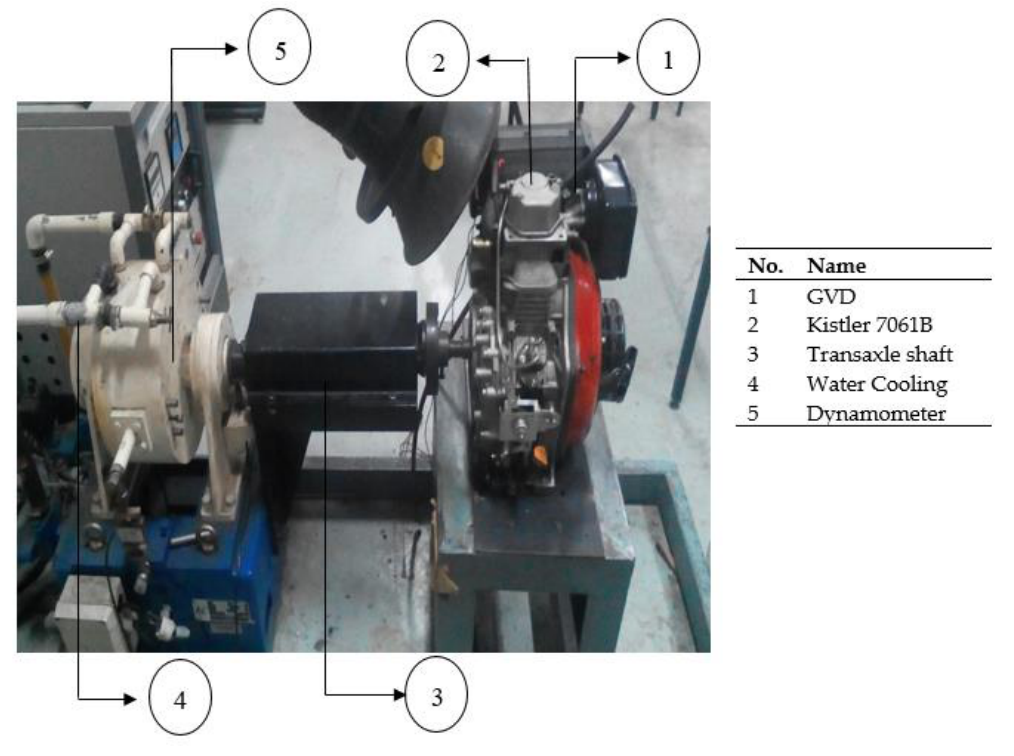
Figure 5. The YANMAR L70AE CI generator diesel engine test rig.